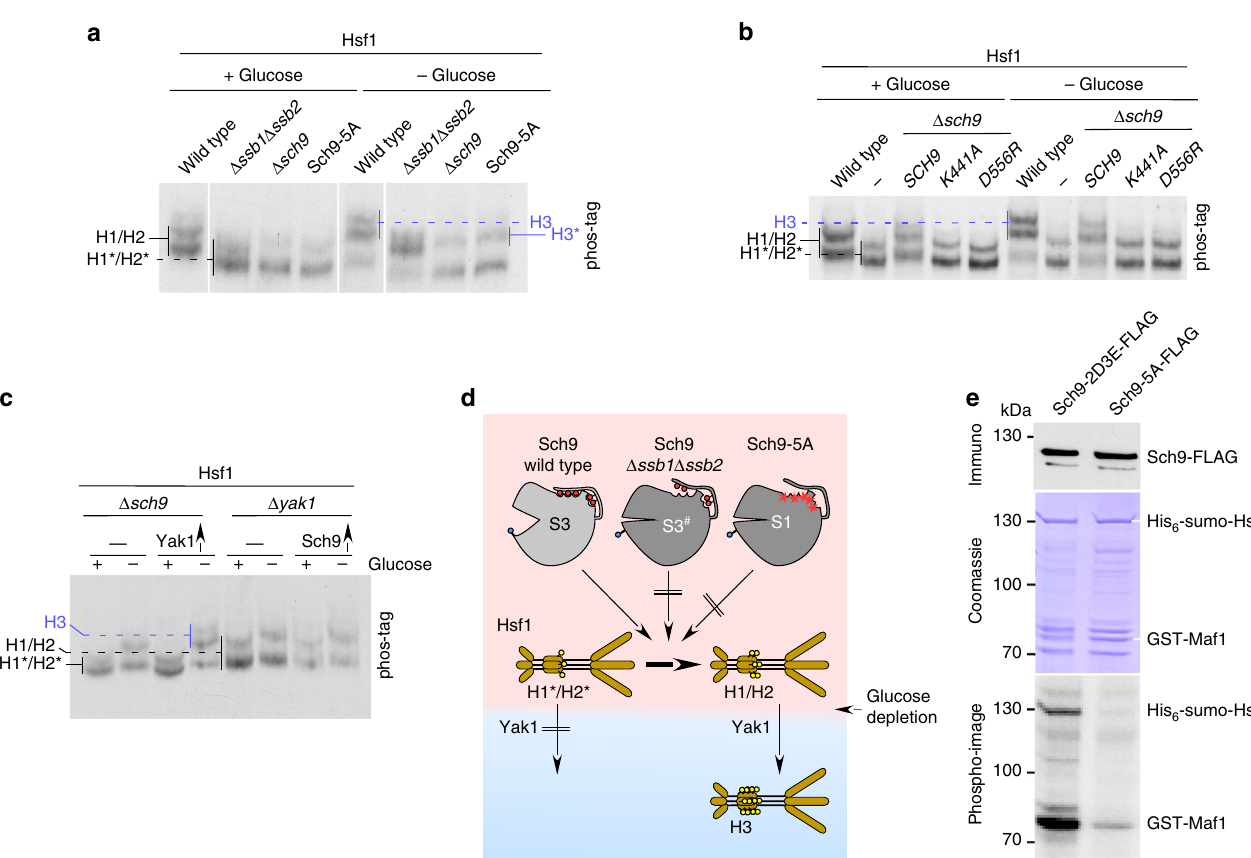
Fig. 5 Sch9 phosphorylates Hsf1 in glucose-rich conditions. a – c Hsf1 phosphorylation is affected by the absence of Ssb or functional Sch9. Strains as indicated were grown on glucose (+glucose) or were glucose depleted for 10 min ( − glucose) prior to collection. Protein extracts were analyzed via phos-tag gels followed by immunoblotting with α -Hsf1. H1/H2: predominant Hsf1 species in glucose-grown wild-type ( a , b ) and Δ yak1 ( c ) cells; H1*/H2*: faster migrating species in Δ ssb1 Δ ssb2 cells, Δ sch9 cells, or in cells expressing non-functional Sch9 versions as indicated. H3: predominant hyper-phosphorylated Hsf1 species formed upon glucose depletion. H3*: hypo-phosphorylated Sch9 species form in cells lacking Ssb or active Sch9 upon glucose depletion. Arrows indicate overexpression of Sch9 or Yak1, respectively. d Cartoon summary of Hsf1 phosphorylation in glucose-rich and glucose-starved conditions. In glucose-grown wild-type cells Hsf1 is phosphorylated to H1/H2. In glucose-grown Δ ssb1 Δ ssb2 cells, or in cells lacking functional Sch9, Hsf1 is hypo- phosphorylated to H1*/H2*. Yak1, activated upon glucose depletion, ef fi ciently phosphorylates H1/H2 to H3, however, does not ef fi ciently phosphorylate the hypo-phosphorylated species H1*/H2*. e Sch9 phosphorylates Hsf1 in vitro. A mixture of partially puri fi ed His 6 -sumo-Hsf1 and GST-Maf1 was incubated with Sch9-2D3E-FLAG or Sch9-5A-FLAG in the presence of γ - 32 P-ATP (see Methods section). The total amount Sch9-2D3E-FLAG or Sch9-5A- FLAG in the reaction was analyzed via immunoblotting with α -FLAG ( upper panel ), total proteins in the reactions were visualized by Coomassie staining ( middle panel , and see also Supplementary Fig. 5), incorporation of 32 P was analyzed via exposure of the Coomassie stained gel to a phosphor image